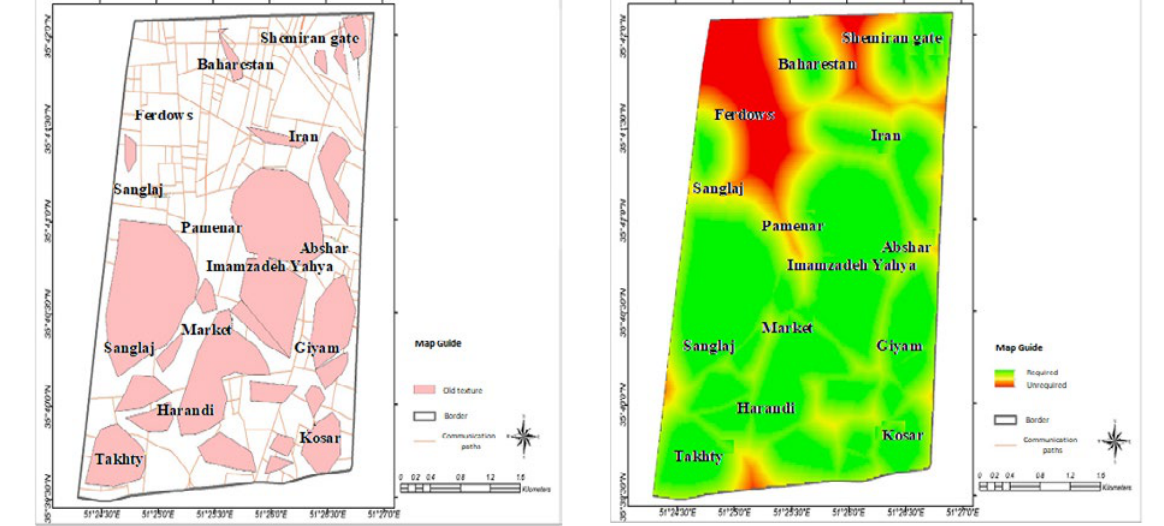
Fig. 5: Distance map of old texture in the District Fig. 6: Fuzzy layer of old texture in the District